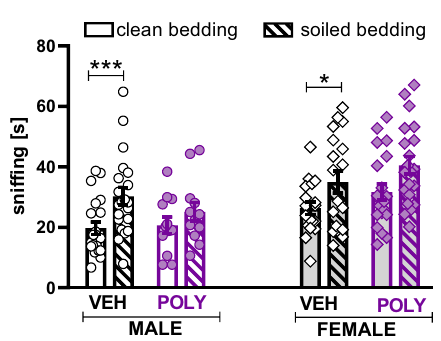
Figure 8. Olfactory preference test. Poly (I:C) exposure reduced preference for social stimuli. Data are presented as a mean ± SEM of time spent sniffing clean and soiled bedding. Symbols: *p < 0.05,***p < 0.001, a significant difference between clean and soiled bedding exploration in a given group (paired Student’s t-test).